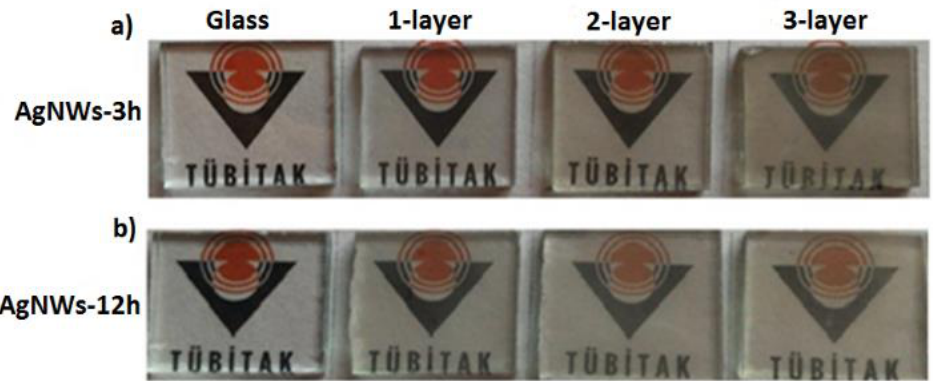
Figure 3. Macro images of 1-, 2-, and 3-layered AgNWs film with di ff erent deposition time for 3h ( a ) and 12 h ( b ).